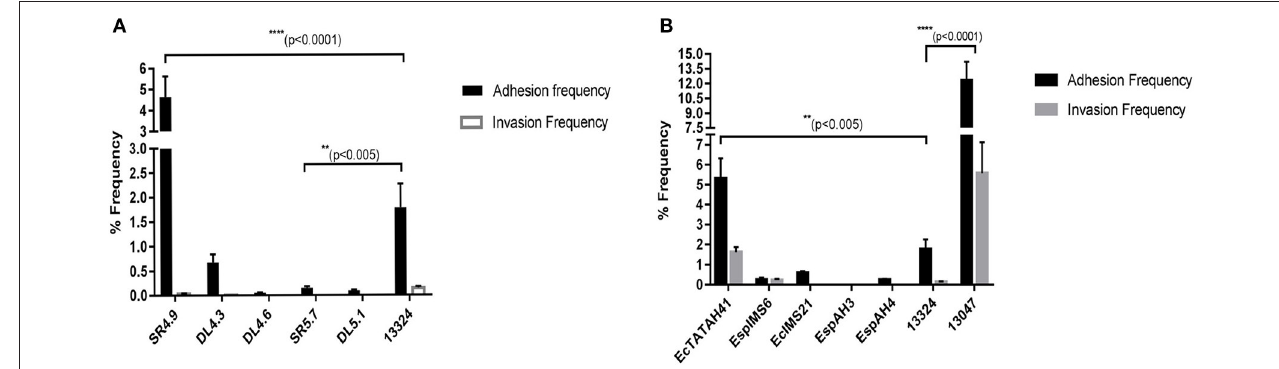
FIGURE 3 | Cell adhesion and invasion frequency of Enterobacter isolates. The bar graph represented the % adhesion and invasion frequency of selected MDR environmental (A) and clinical (B) Enterobacter isolates, which was calculated by the % ratio of the number of viable bacterial cells (as in mean log 10 CFU/ml) after infection to RAW 264.7 cell line and the initial inoculum given. Statistical significance was determined using two-way ANNOVA test using GraphPad Prism software and S. typhii ATCC 13324 as control, where **** p < 0.0001 and ** p <